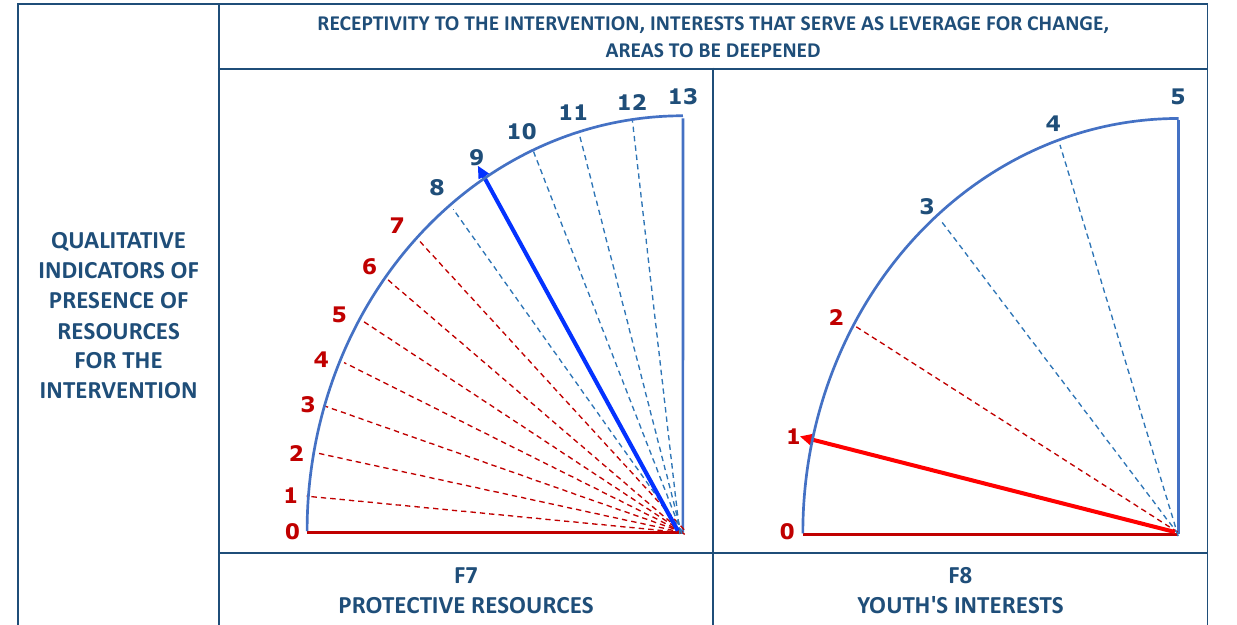
Figure 2. Example for mapping of FER ‐ R resources.